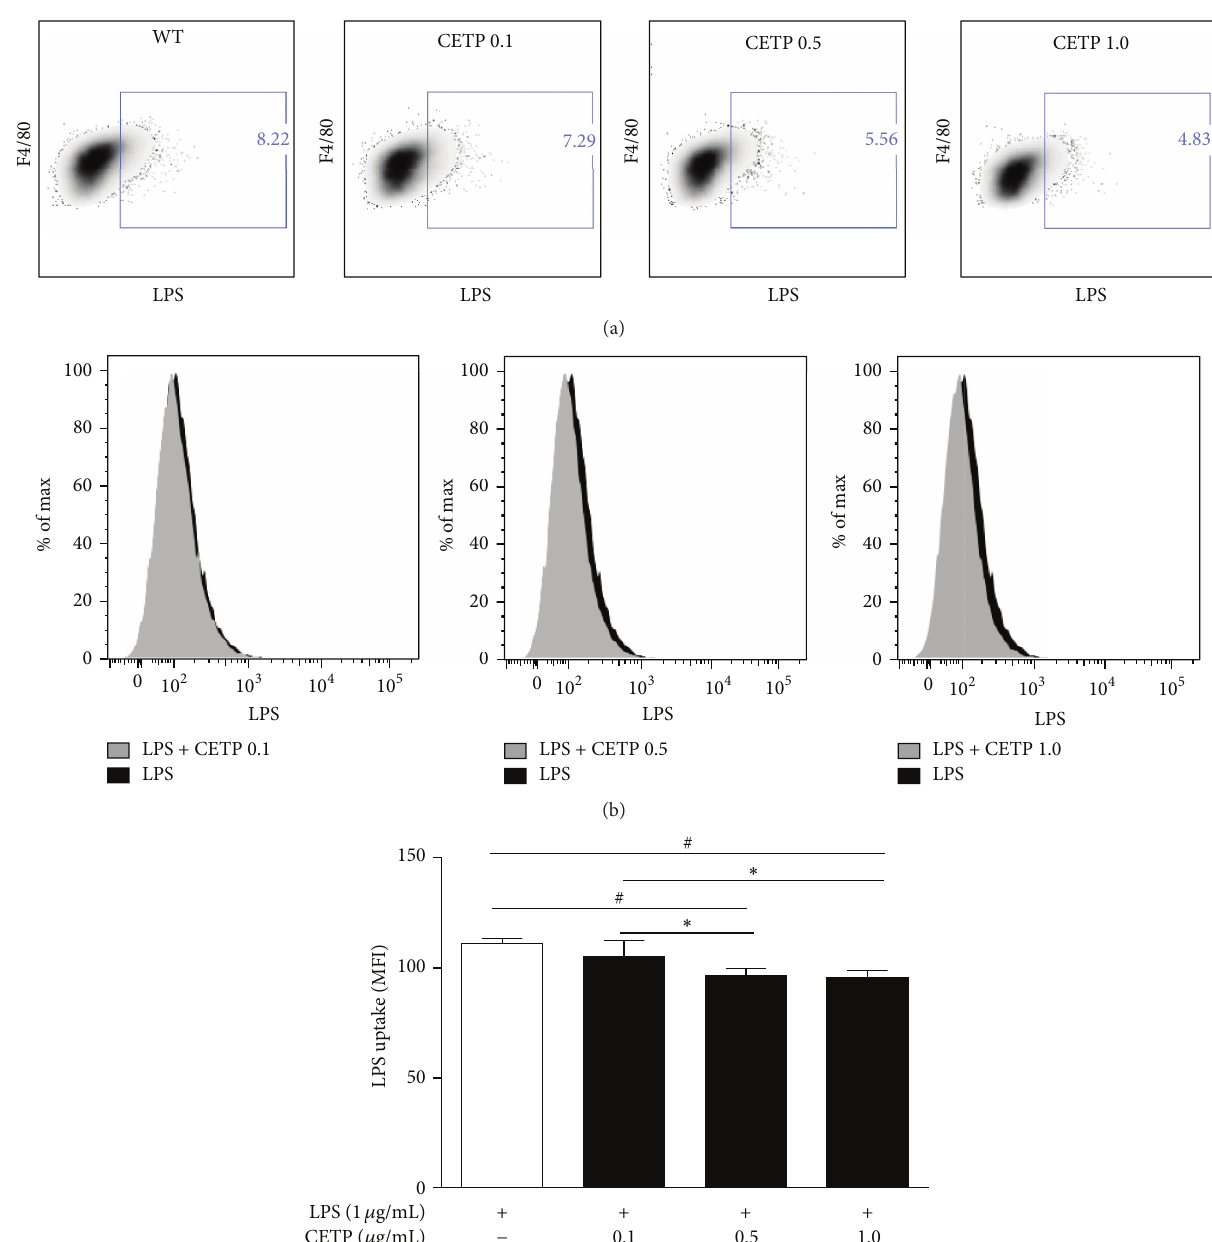
Figure 5: CETP reduces macrophage LPS uptake after LPS stimulus. Peritoneal macrophages obtained from WT mice were stimulated for 24 h with LPS-Alexa Fluor (cid:2) 488 (1 𝜇 g/mL) in the absence or presence of CETP (0.1, 0.5, and 1.0 𝜇 g/mL). (a) Representative FACS dot plots gatedonF4/80 + cells(macrophagesonly)andthepercentageofLPS-Alexa488 + cellsareshown.(b)Representativeflowcytometryhistograms comparing macrophages (F4/80 + ) from WT and respective CETP groups stimulated with LPS. (c) Graph presented as mean ± SD of MFI (median fluorescence intensity) analyzed using FACSDiva software ( 𝑛 = 4) representative of three independent experiments, by one-way ANOVA 𝑝 = 0.0014 and posttest (Newman-Keuls Multiple Comparison Test; ∗ 𝑝 < 0.05 and # 𝑝 < 0.01